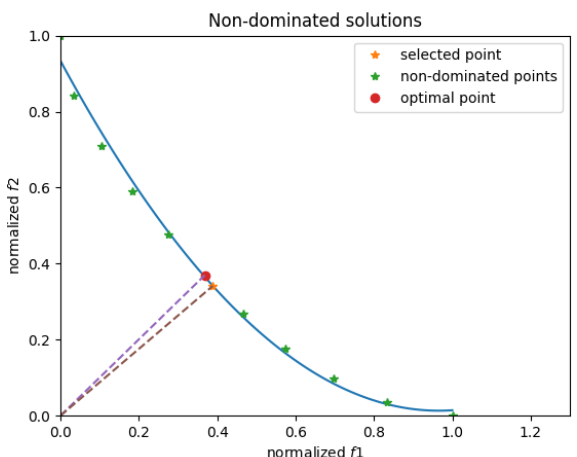
Figure 1. If we want to improve the compromise solution, a denser Pareto front is required [34], so we could select a better solution among the front. However, optimizing the criterion directly could find a better compromise solution and avoids looking for other non-dominated